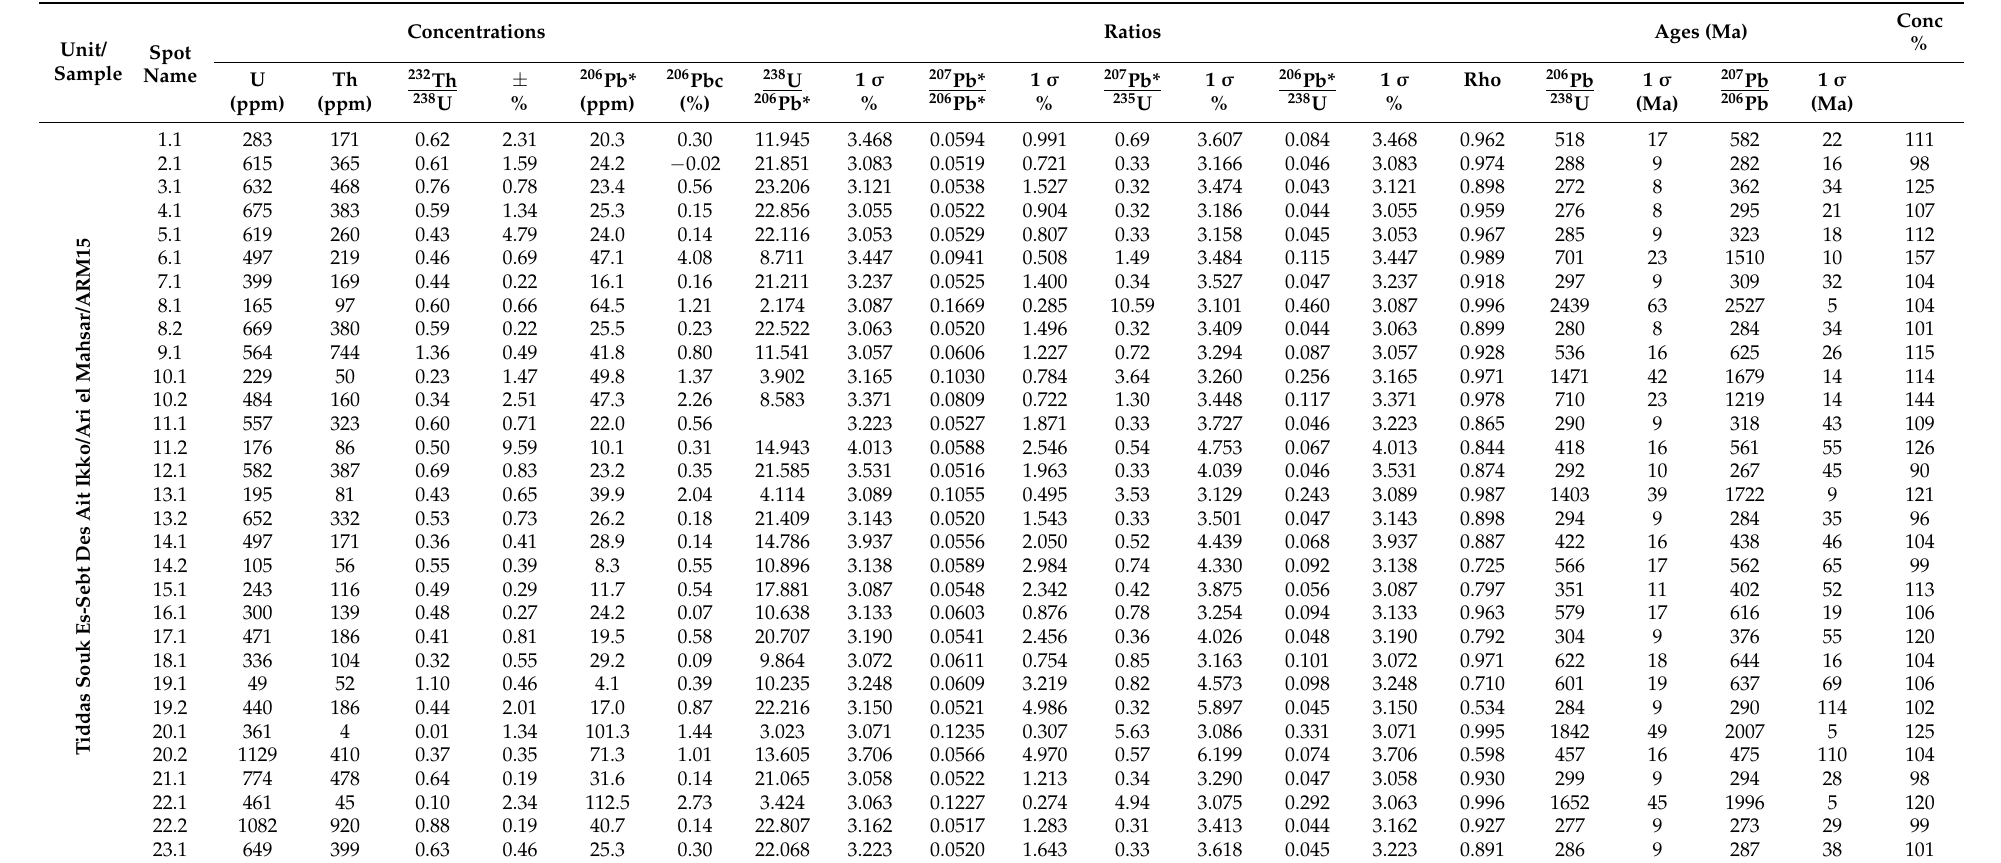
Table 2. SHRIMPII zircon U–Th–Pb results of the rhyolitic dome of